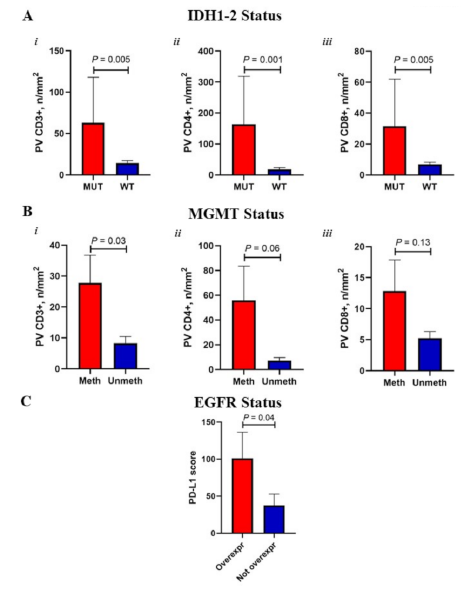
Figure 3. Correlations between TIME and genetic-molecular characteristics. Bar charts reporting Mean (+St.Err) values of perivascular CD3+ ( i ), CD4+ ( ii ) and CD8+ ( iii ) TILs according to IDH1-2 ( A ) mutational and MGMT ( B ) methylation status. ( C ): bar graphs illustrating the extent of PD-L1 tumor score according to EGFR